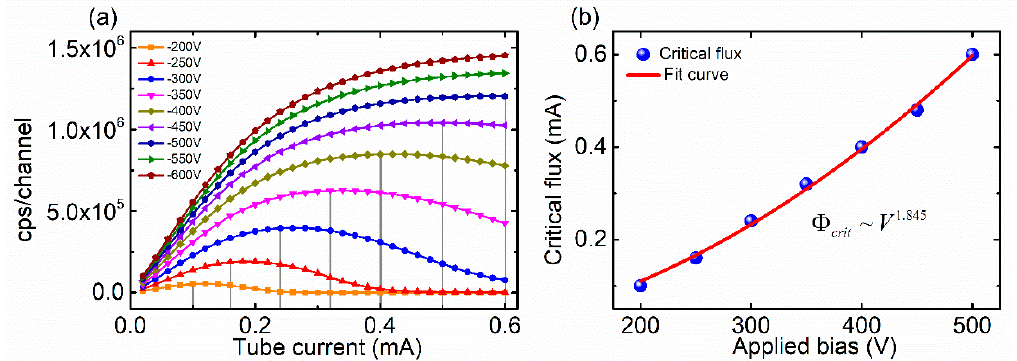
Figure 2. ( a ) Count rate performance of a typical pixel as a function of applied bias; ( b ) fit result of critical flux vs. applied bias.